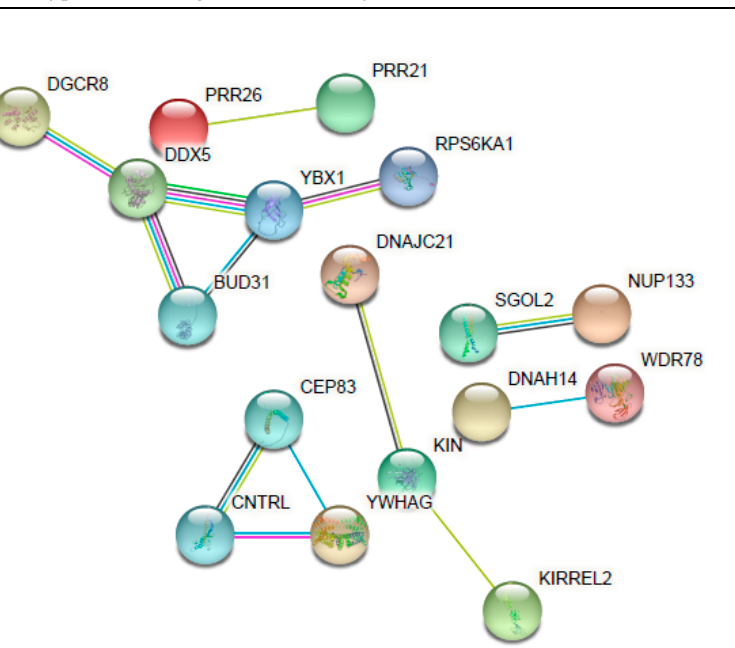
Figure 4. Interaction network of the main altered genes (upregulated and downregulated) for their response to disulfiram. Each gene is represented as a node and each line represents the number of interactions between genes. Image was created using the STRING Database.